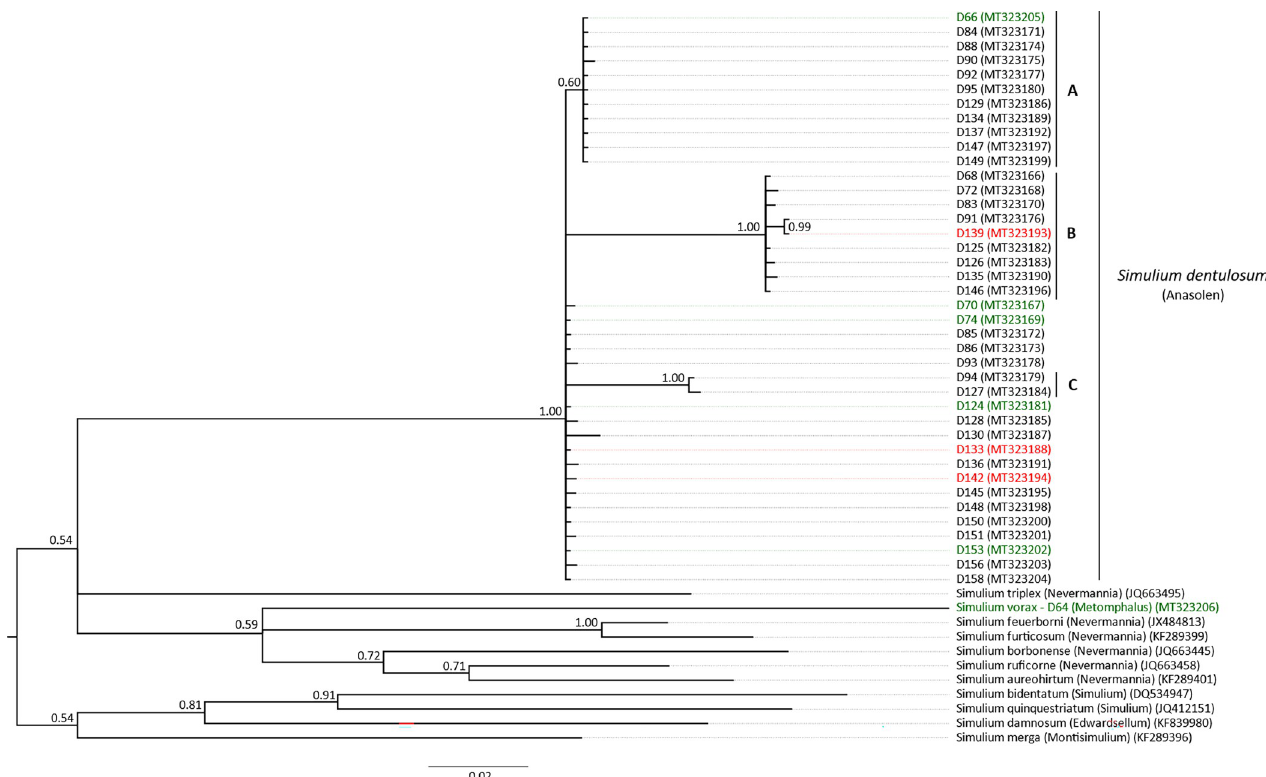
Fig 3. Phylogenetic tree based on the mitochondrial sequences (COI, 658 bp) of specimens identified as Simulium dentulosum and Simulium vorax from Kakoi-Koda Focus. The analysis was performed with Bayesian inference under the GTR + I + G model of sequence evolution. The green and red colours indicate specimens identified as “infected” by either O . volvulus and O . ochengi and “infective” for O . volvulus , respectively. The sequenced S . vorax specimen was infected with O . volvulus . Posterior probabilities are indicated at the nodes. GenBank accession numbers of sequences are indicated between brackets.